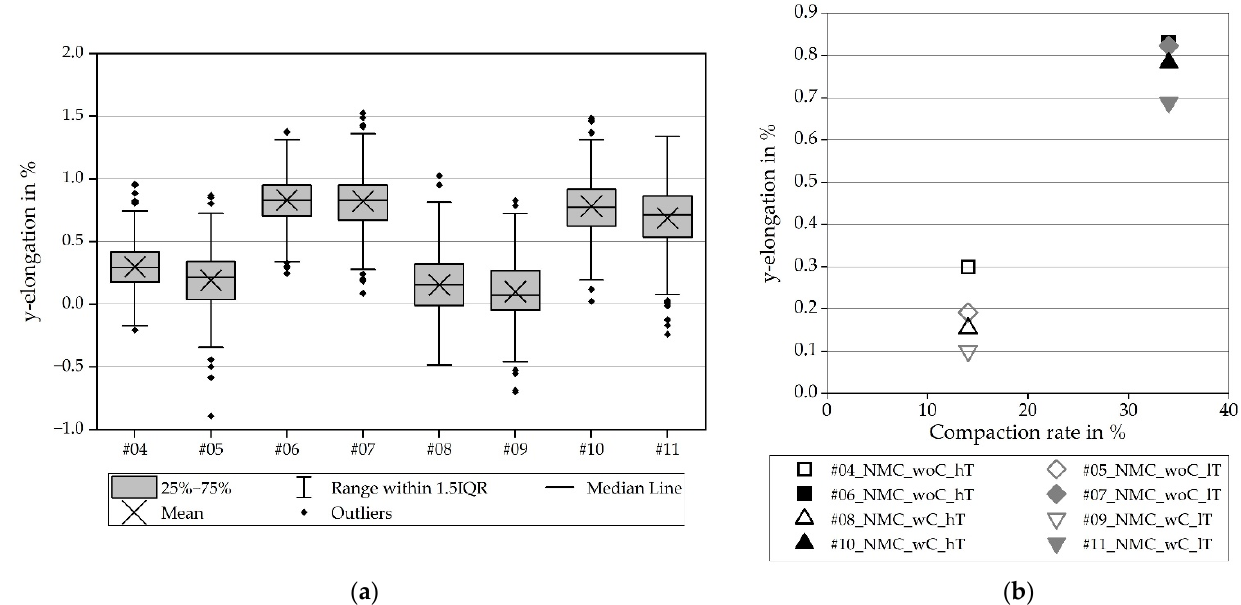
Figure 11. Elongation in the y-direction for NMC811: ( a ) all values including the scatter; ( b ) average values.